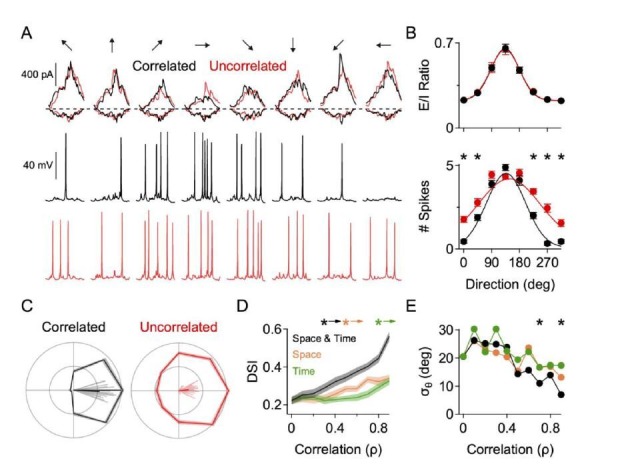
Correlated excitation and inhibition is critical for accurate and reliable direction selectivity.These data are from a NEURON model (as described in the main manuscript) where the spatiotemporal correlation between the excitatory and inhibitory inputs was manipulated. Temporal correlation is the likelihood that, at a given dendritic site, that excitation and inhibition arrive at the same time. Spatial correlation is defined as the likelihood that, at a given site, if excitation arrives that inhibition will arrive at the same location. A, Top, EPSCs and IPSCs measured at the soma in correlated and uncorrelated states in response to 8 different simulated directions of motion. NaV activity is blocked for these recordings. Middle, Somatic spiking in response to correlated E/I inputs. Bottom, Somatic spiking in response to uncorrelated E/I inputs. Somatic and dendritic NaV were active for the spike recordings. Note, the somatic currents are roughly the same in correlated and uncorrelated conditions, but more null spikes arise in the uncorrelated case. B, Top, E/I ratio across direction (measured at the soma) is similar in the correlated and uncorrelated states. Bottom, Directional tuning of the spiking response in the correlated and uncorrelated states. Note the increase in null spikes during non-preferred motion for the uncorrelated state. C, Polar plot form and vector angles (lines) of the directional tuning in correlated and uncorrelated states. D, DSI as a function of spatial and temporal correlation strength. Here, the spatial and temporal correlation was modeled independently. E, Same as D, but for the angular standard deviation. * indicates statistical significance p < 0.05 (t-test)..